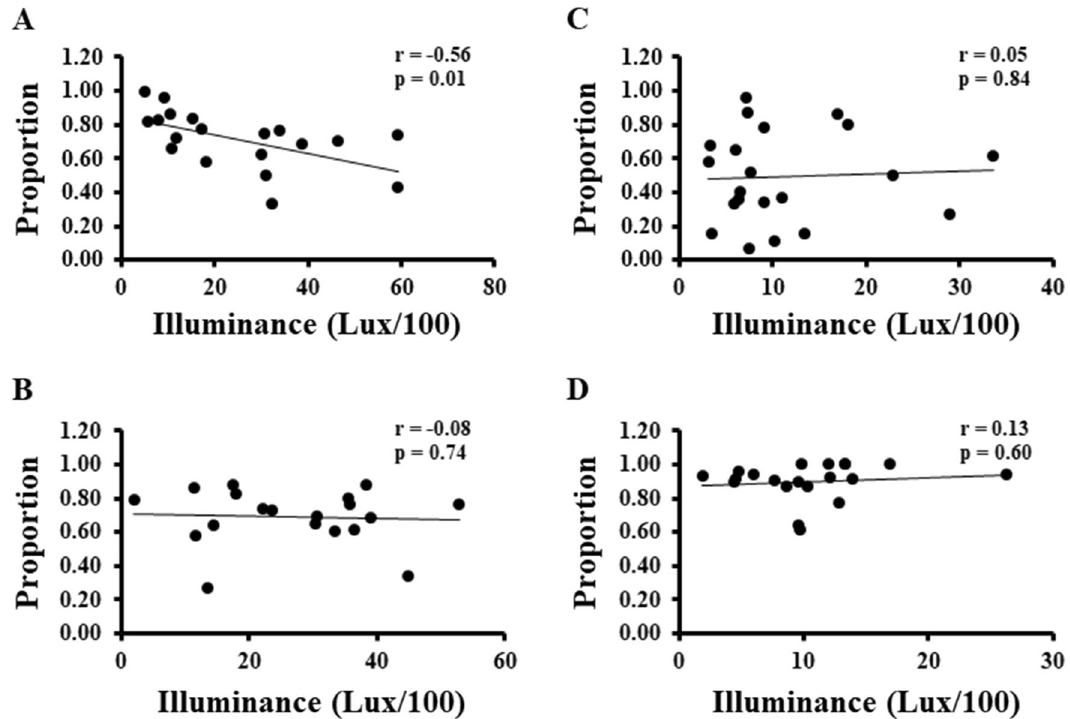
Figure 7. The relationship between the proportion of individuals with expanding tentacles from their tubes and illuminance in spring ( A ), summer ( B ), autumn ( C ), and winter ( D ). ( A ) March to May; ( B ) June to August; ( C